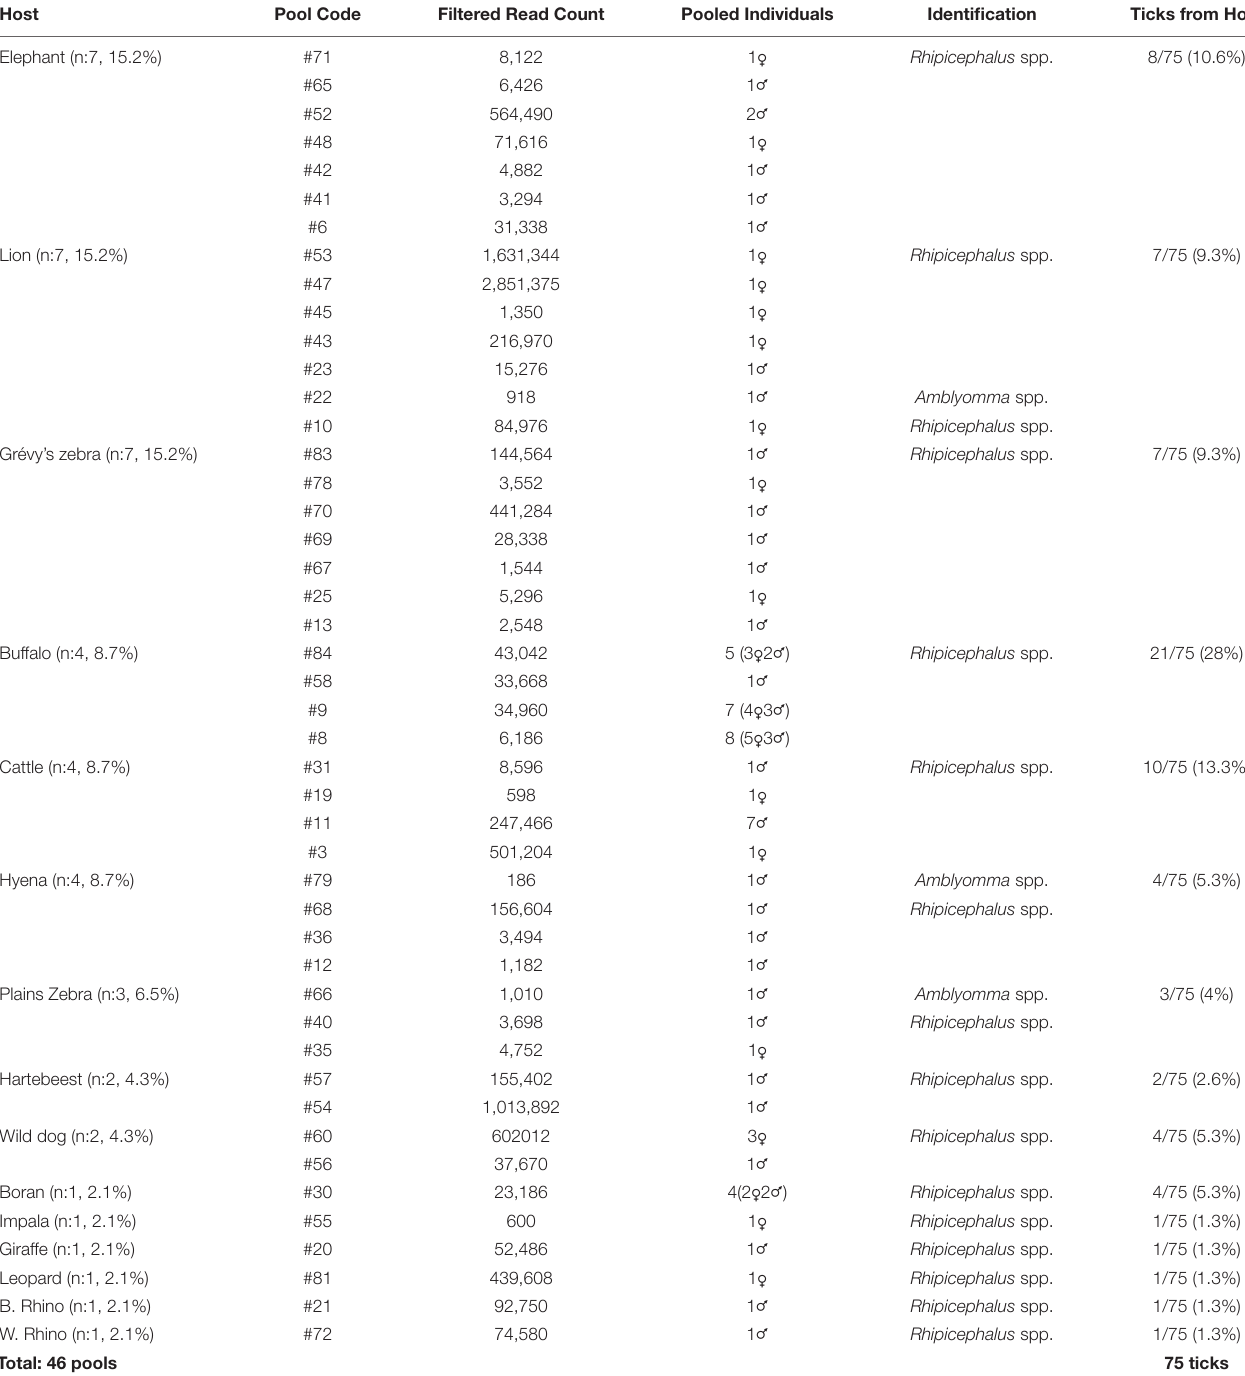
TABLE 1 | Overview of the tick specimens and their hosts included in the